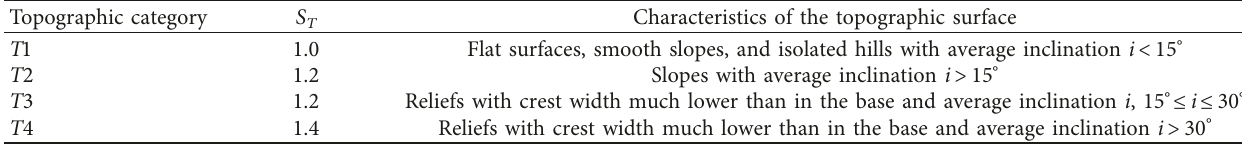
Table 7: Topographic amplification coefficient in the Italian code [17]. Topographic category